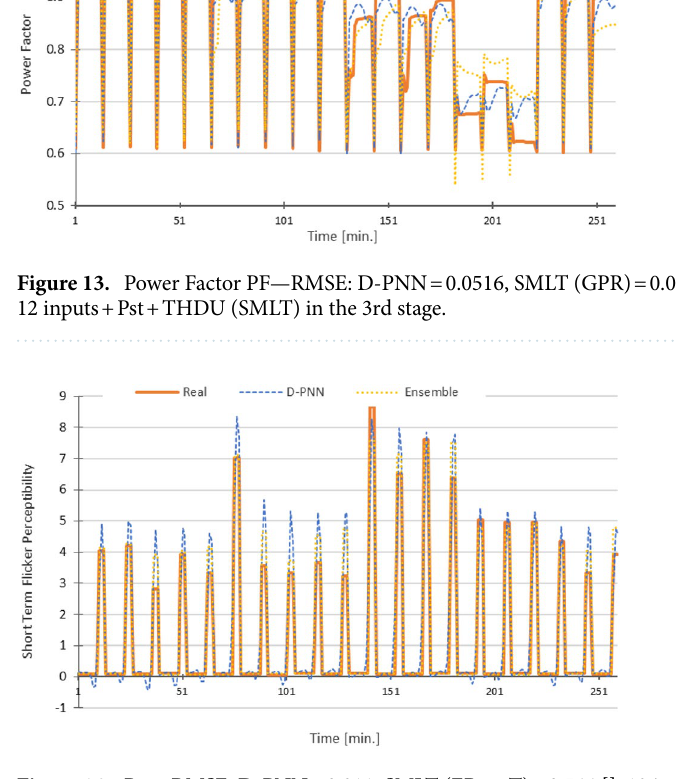
Figure 14. Pst—RMSE: D-PNN = 0.811, SMLT (EBoosT) = 0.544 [], 12 inputs + Pst (both D-PNN and SMLT) in the 2nd